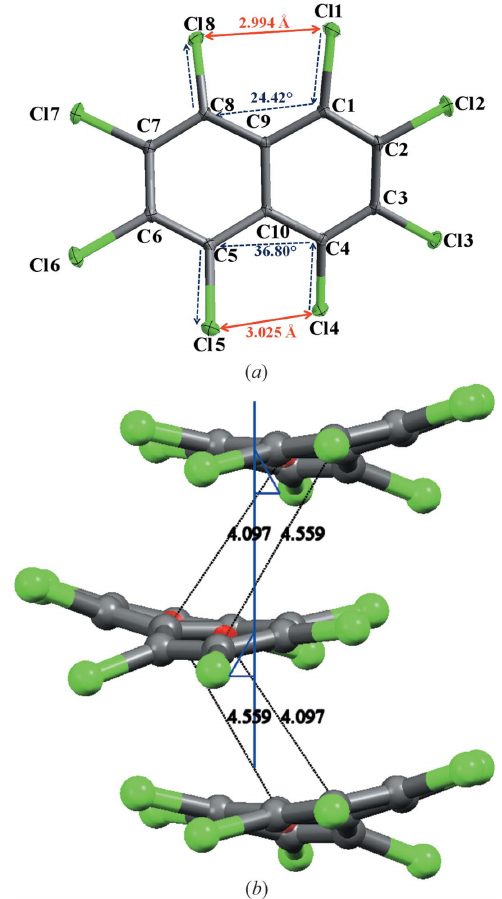
Figure 2 ( a ) ORTEP representation of the structure of OCN at 100 K. Atom ellipsoids are shown at the 50% probability level. ( b ) Molecular packing diagram along the 2 1 screw axes parallel to the b